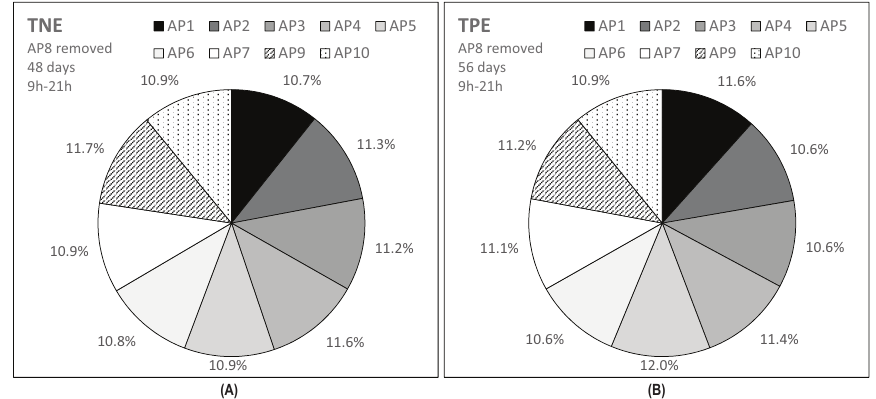
Figure 8. Energy distribution among the APs in the simulated network ( A ) and new network ( B ).